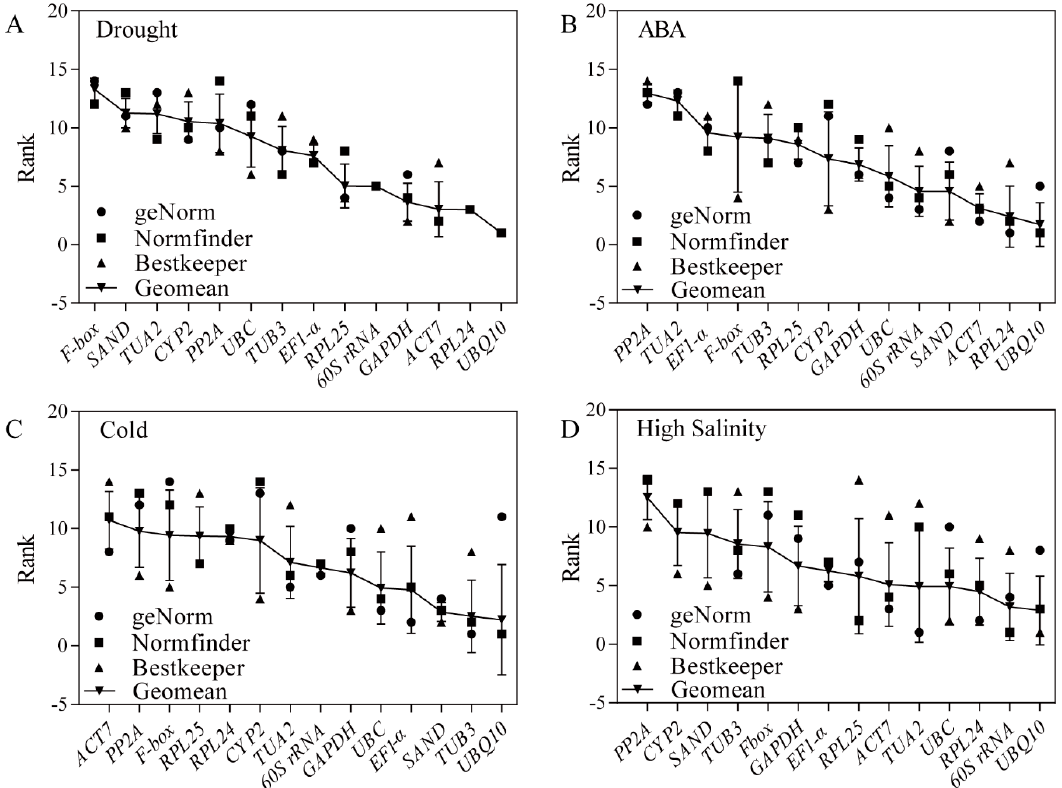
Figure 4. Comprehensive ranking of the fourteen RGs across all stresses and ABA treatment calculated as the geometric mean (Geomean) of three types of ranking (geNorm, NormFinder, and BestKeeper) for each sample group. ( A ) Drought stress, ( B ) ABA treatment, ( C ) cold stress, and ( D ) high salinity stress.